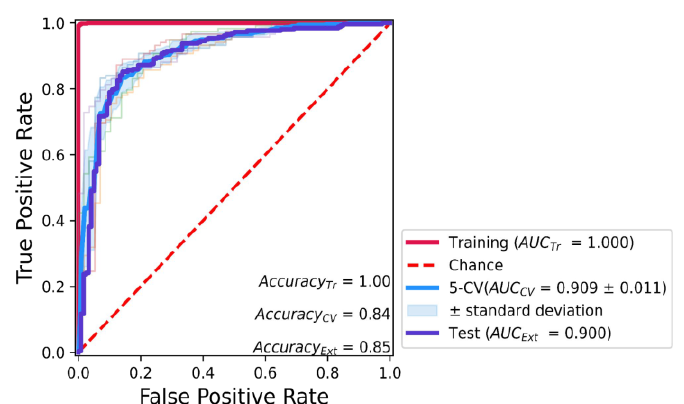
Figure 2. Classification model for predicting against KRAS G2C ligand affinity. The red, blue, and purple solid lines indicate the training, 5-fold cross-validation (5-CV), and test datasets, respectively. The red dashed line indicates the random decision by chance of the model. The light blue area indicates the standard deviation of 5-fold cross-validation.